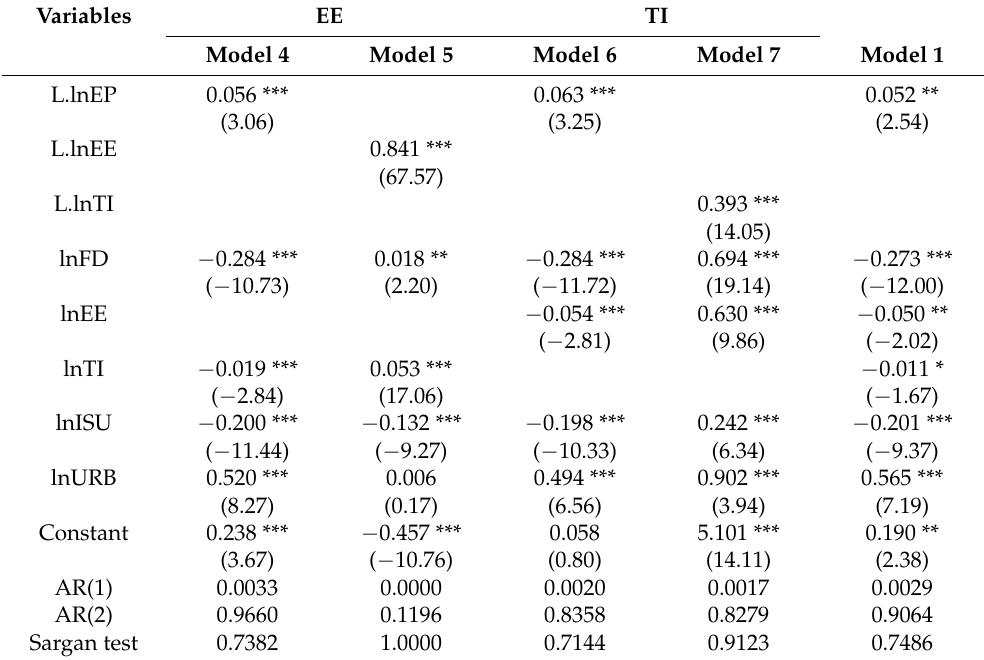
Table 7. Results of the mediation